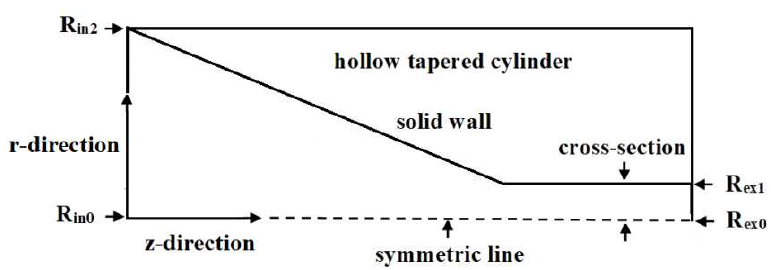
Figure 2. Numerical domain of calculation in the hollow tapered cylinder.